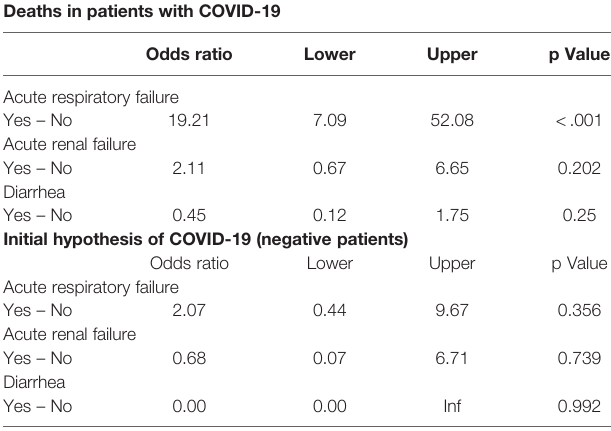
TABLE 4 | Binomial logistic regression model to verify the association of the variables: acute respiratory failure, acute renal failure, and diarrhea, in the deaths of hospitalized patients with suspected COVID-19, con fi rmed or